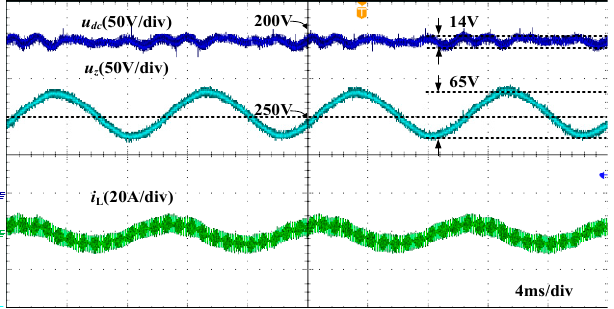
Figure 13. Experiment waveforms when the decoupling capacitor voltage is 250 V.